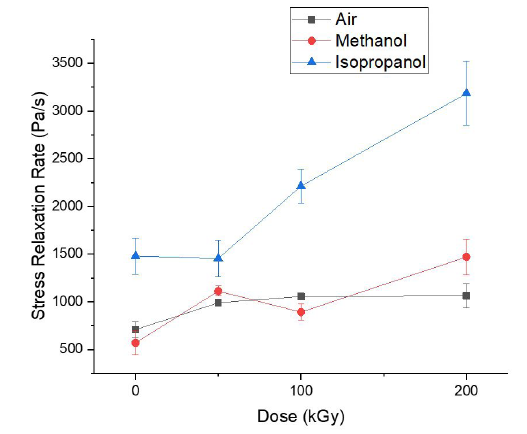
Figure 6. Stress-relaxation rates as a function of absorbed dose for PC in three different